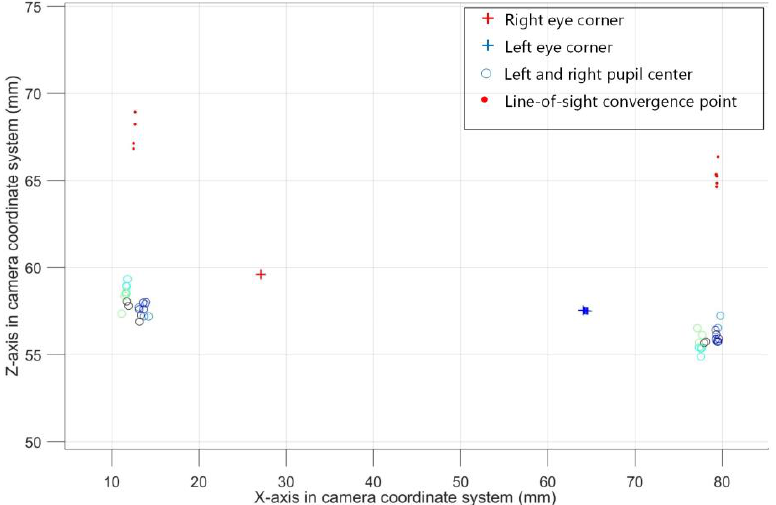
Figure 12. The distribution of the line-of-sight convergence points which are solved in the calibration process, and these points are aligned by the inner eye corner vector.